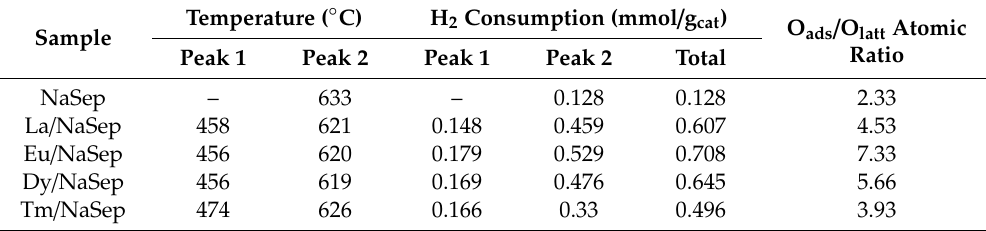
Figure 4. SEM images of ( a ) Eu / NaSep, ( b ) Dy / NaSep, ( c ) La / NaSep, ( d ) Tm / NaSep and ( e ) NaSep. Table 2. Reduction temperatures, H 2 consumption, and O ads / O latt atomic ratios of the